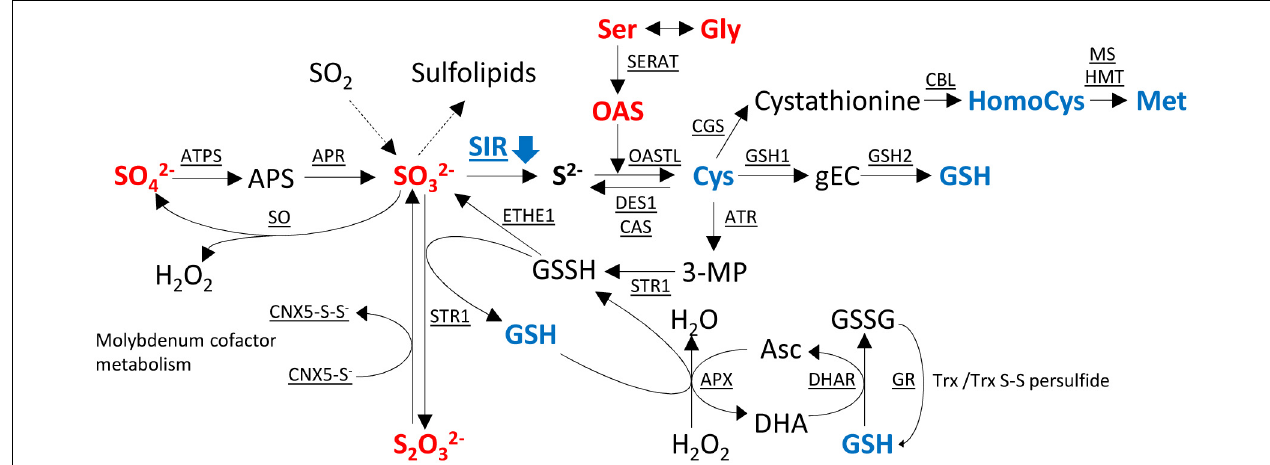
FIGURE 7 | Changes of metabolites in sulfur metabolism in the transgenic SIR co-suppression lines compared to wild-type plants. Metabolites in red indicate increased levels and metabolites in blue indicate decreased levels of the metabolite in the transgenic lines compared to wild-type plants. APS, 5 (cid:48) -adenosine phosphosulfate; gEC, γ -glutamylcysteine; GSH, glutathione; GSSH, glutathione disulfide; OAS, O -acetyl serine; 3-MP, 3-mercaptopyruvate; Asc, ascorbate; DHA, dehydroascorbate; ATPS, adenosine triphosphate sulfurylase; APR, APS reductase; SIR, sulfite reductase; SERAT, serine acetyltransferase; OASTL, O -acetylserine(thiol)lyase; DES1, cysteine desulfhydrase 1; CAS, cyano-alanine synthase; GSH1, γ - L -glutamyl cysteine synthetase; GSH2, glutathione synthetase; CGS, cystathionine γ -synthase; CBL, cystathionine β -lyase; MS, methionine synthase; HMT, homocysteine S -methyltransferase; ATR, aminotransferase; STR1, sulfurtransferase; ETHE1, ethylmalonic encephalopathy protein 1; APX, ascorbate peroxidase; DHAR, dehydroascorbate reductase; GR, glutathione reductase; SO, sulfite oxidase; Trx, thioredoxin; CNX, cofactor for nitrate reductase and xanthine dehydrogenase.